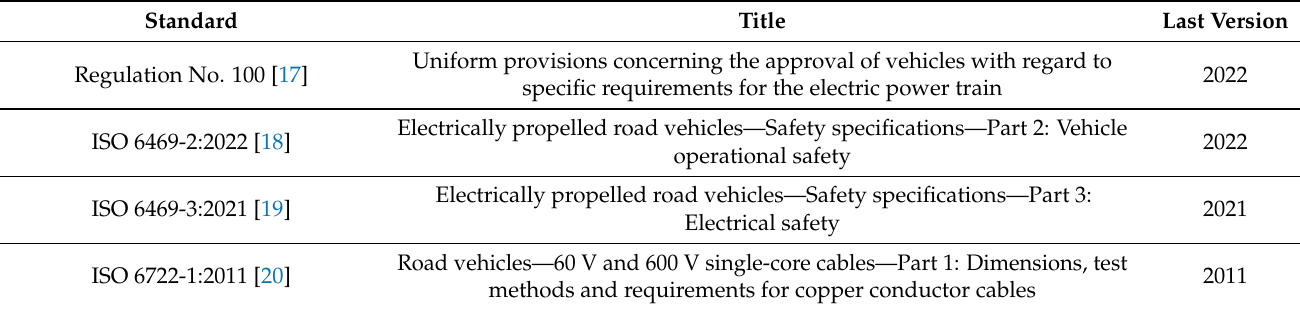
Table 1. Some technical standards related to vehicle